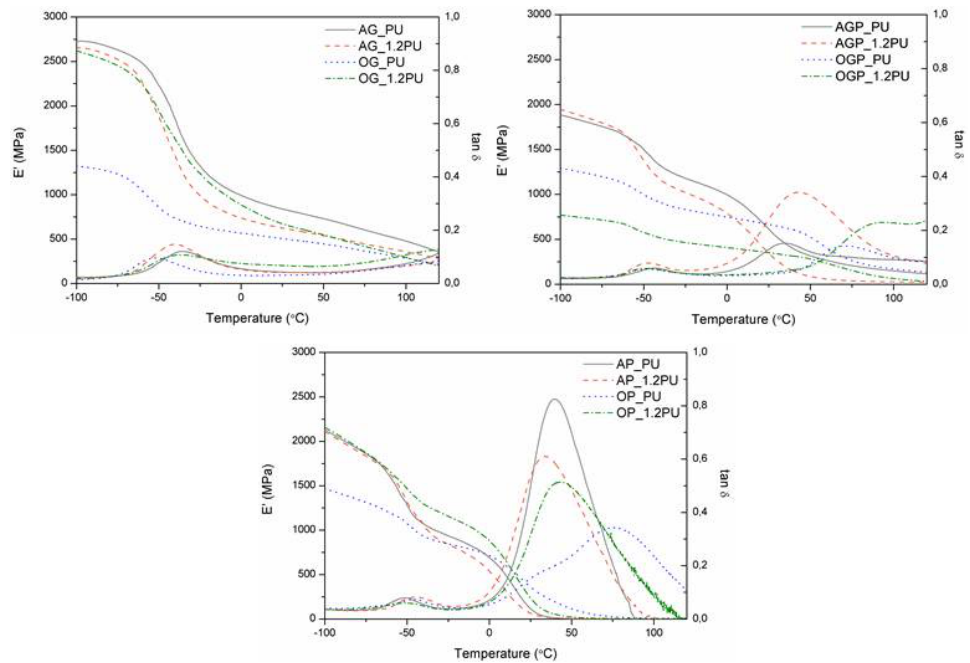
Figure 7. Tan δ and storage modulus (E′) of polyurethane resins . Table 6. Dynamic mechanical and thermal properties of polyurethane resins.